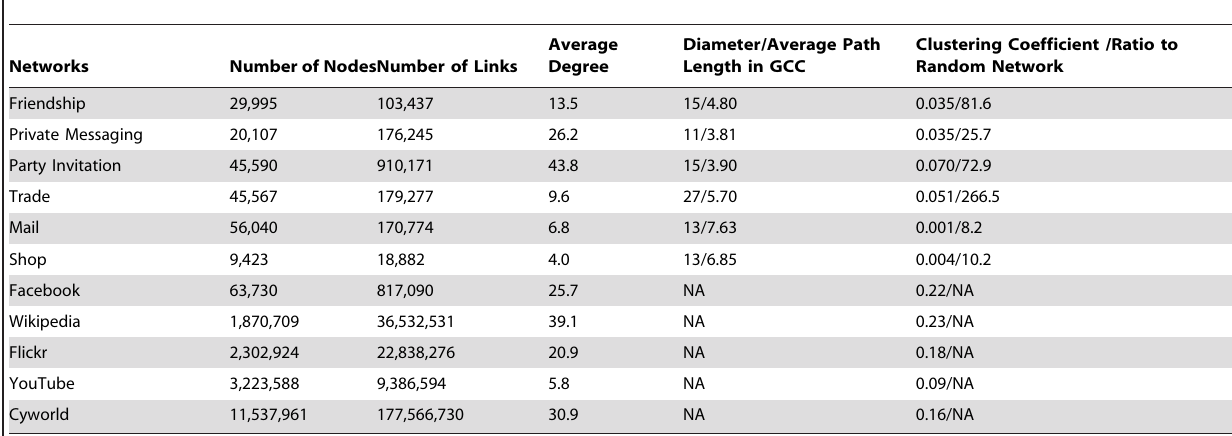
Table 1. Basic network characteristics of AION interaction networks and other popular social networks.